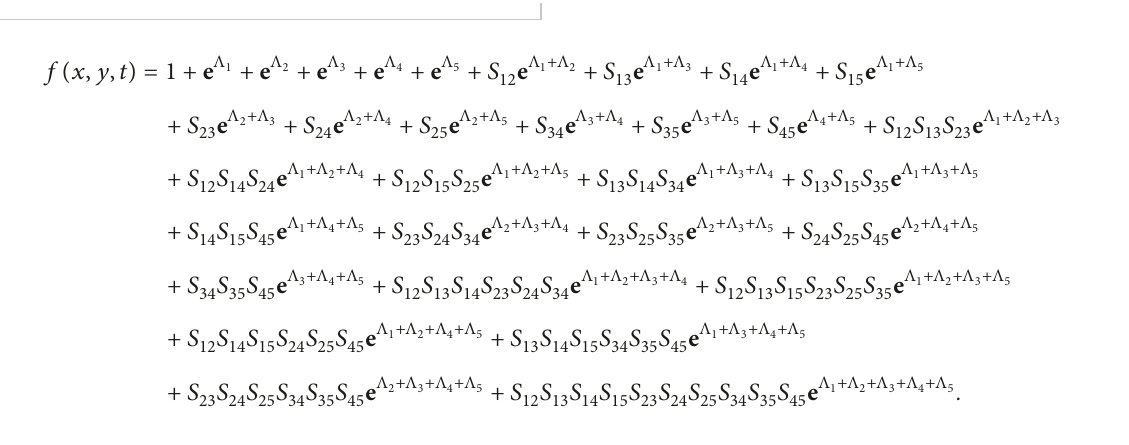
( t ) � 1 , ϕ ( t ) � cos ( t + 3 ) , c 1 9